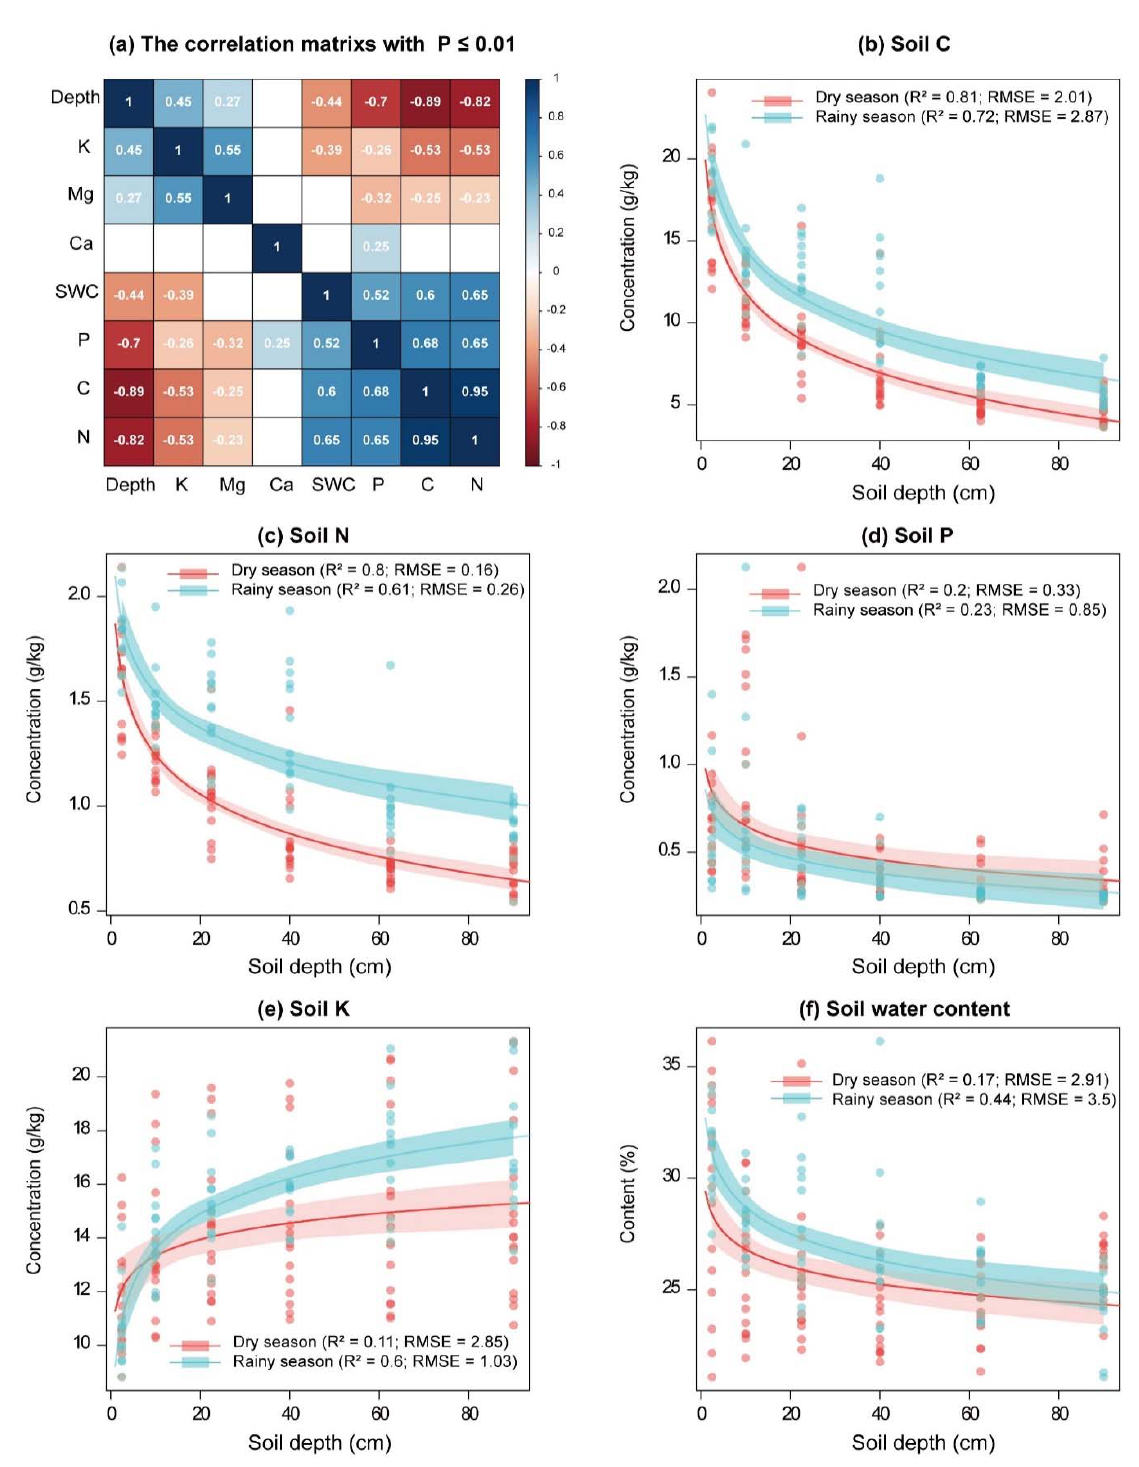
Figure 2. ( a ) Correlations between soil depths and different soil nutrients and variations in ( b ) soil C, ( c ) soil N, ( d ) soil P, ( e ) soil K concentrations, and ( f ) soil water content with depth. The translu ‐ cent ribbons around the fitting curves indicate 95% confidence bands. RMSE, root mean square er ‐ ror.